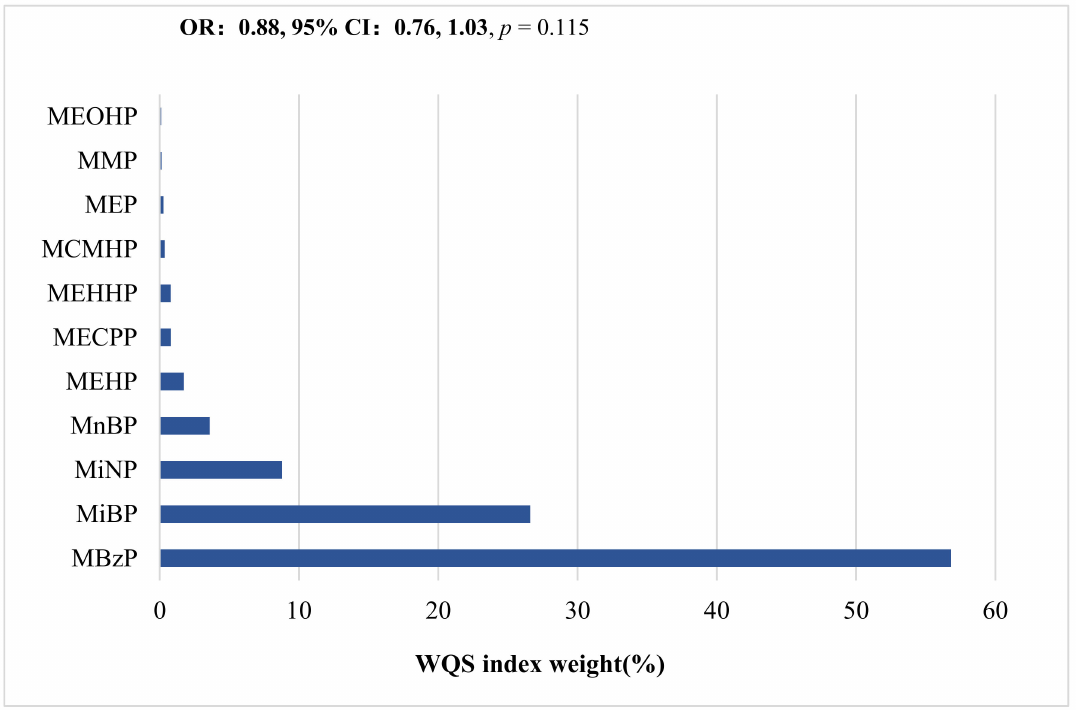
Figure 3. Weighted quantile sum (WQS) regression analysis of the association of urinary phthalate metabolites with asthma. Bar graphs show the magnitude of the WQS weight for each metabolite. Models are adjusted for creatinine, passive smoking during pregnancy, annual income, and raising a furry or feathery pet for the odds ratios (95% confidence interval) for association between phthalate metabolites and